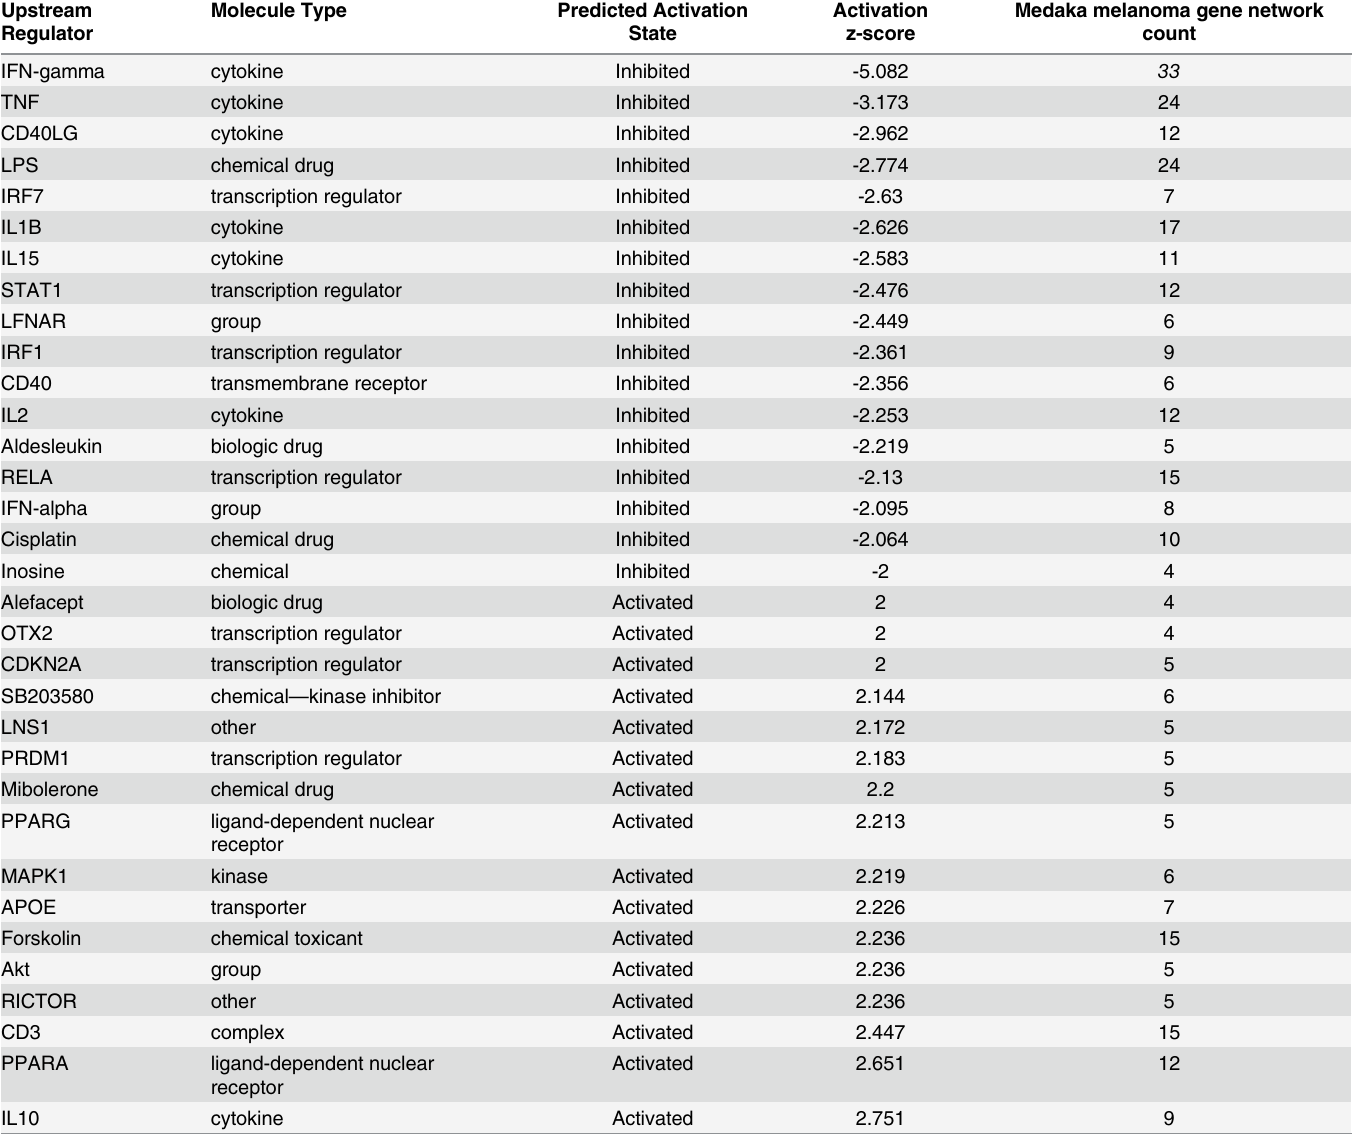
Table 1. Estimated activation state for inferred melanoma gene network